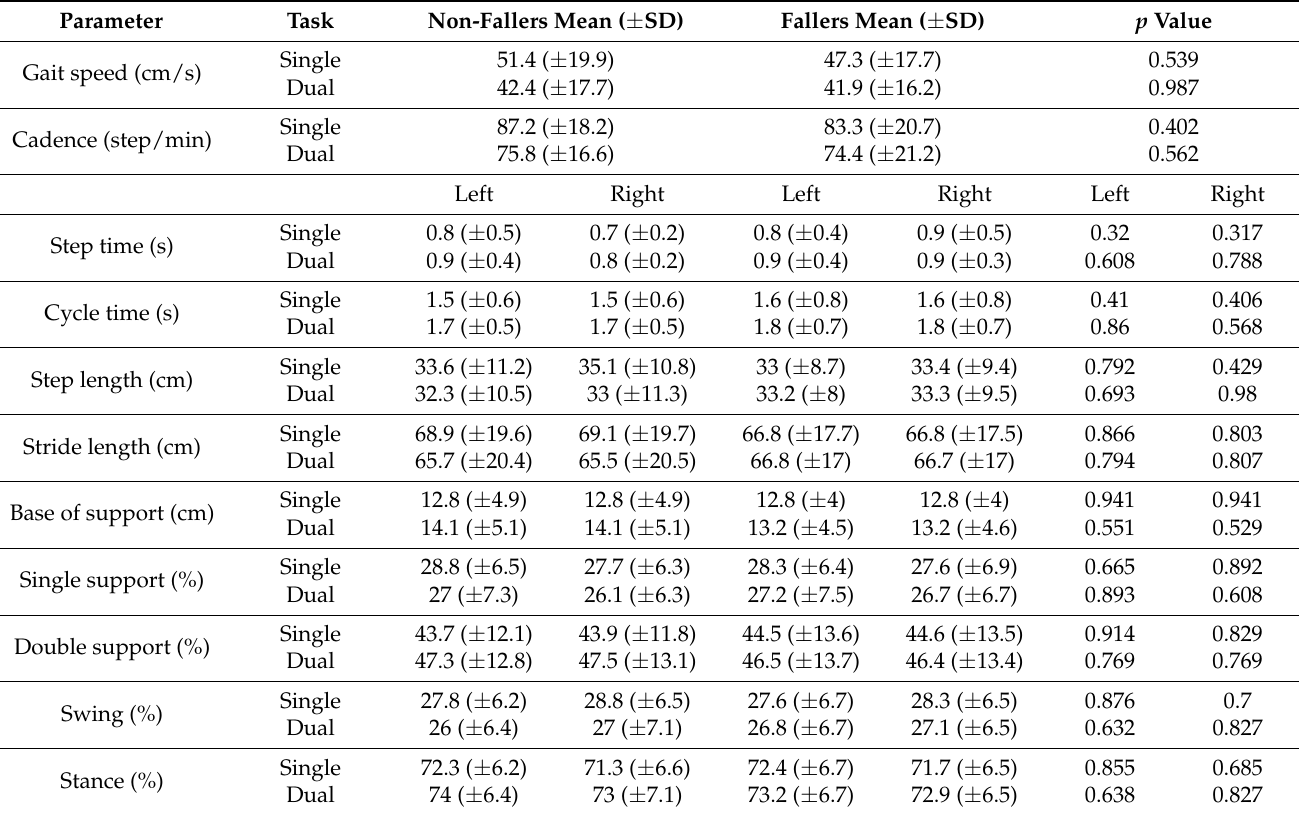
Table 3. Gait parameters and comparison between fallers and non-fallers.